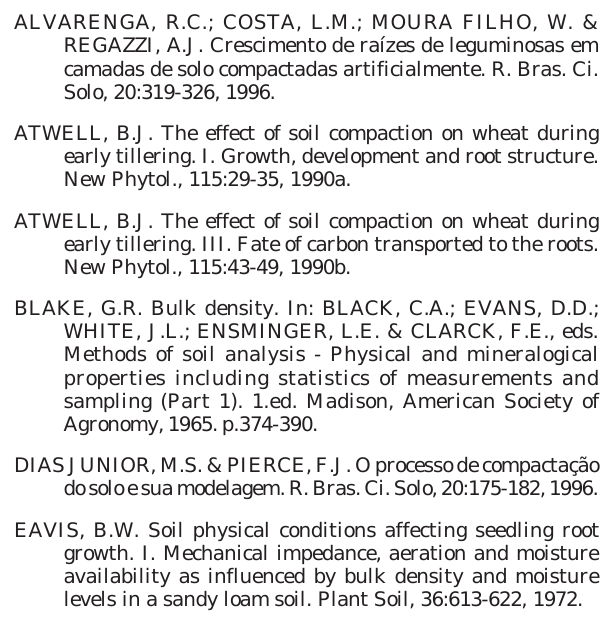
Figure 3. Wheat root mass (a) and length (b) densities under different soil strengths.